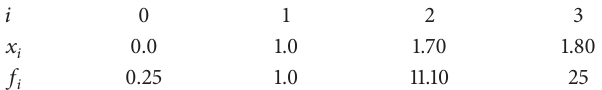
Table 3: A positive data from work by Hussain et al. [10].